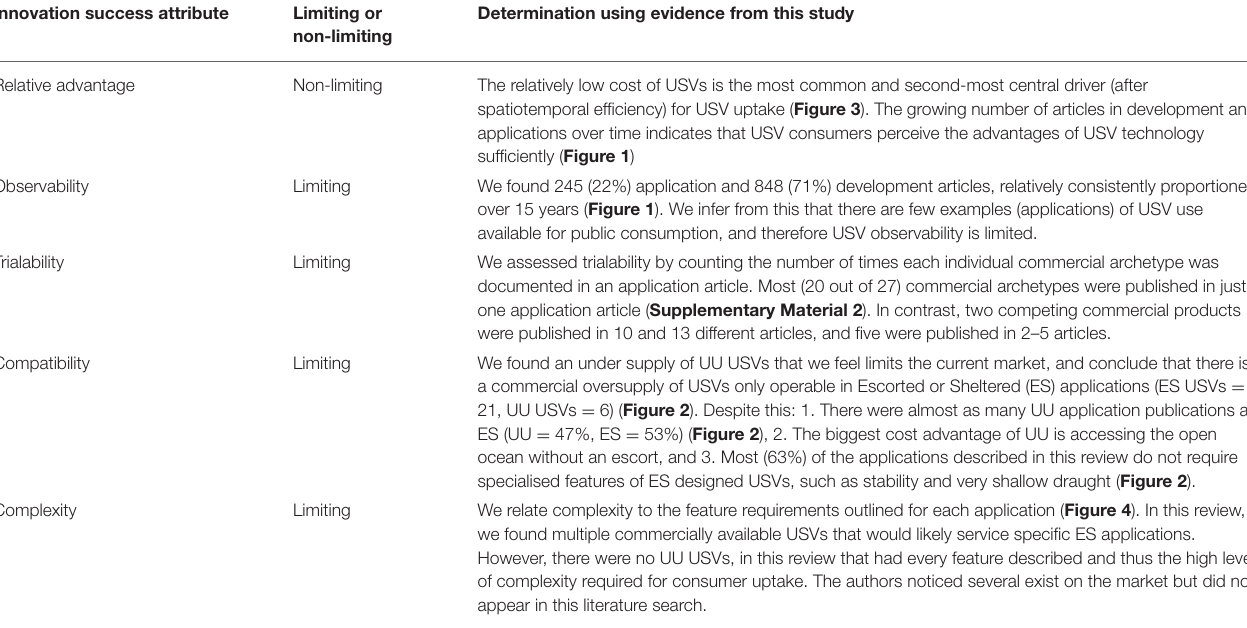
TABLE 2 | Technology diffusion innovation success attributes that are limiting or non-limiting to the diffusion of USV